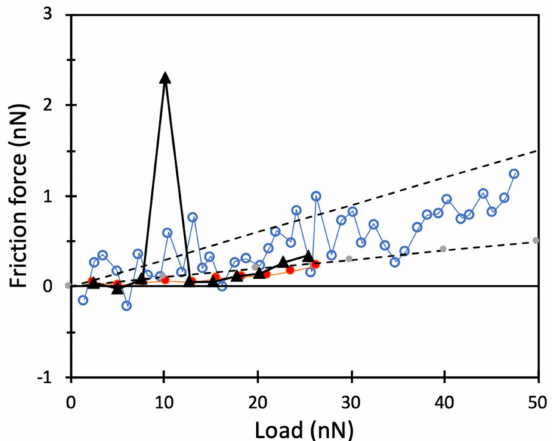
Figure 3. Friction force as a function of normal load. Data for DPPC bilayers on silica (unfilled circles) as well as for an adsorbed layer formed after 40 min adsorption from a 155 mM NaCl solution containing 0.5 mg/mL DPPC and 0.5 mg/mL hyaluronan, followed by rinsing (red filled circles). Additionally illustrated is one friction measurement depicting high friction force at a normal force of 10 nN (black triangles). The temperature was 47 ◦ C. The upper and lower dashed lines have a slope of 0.03 and 0.01,